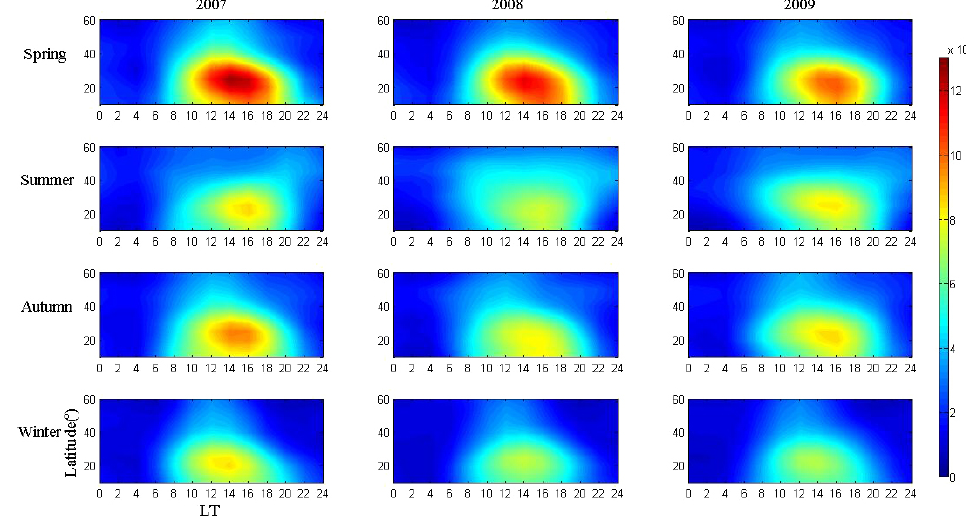
Figure 3. Latitudinal, diurnal and seasonal variation in Nm F2 during the low-solar-activity period of